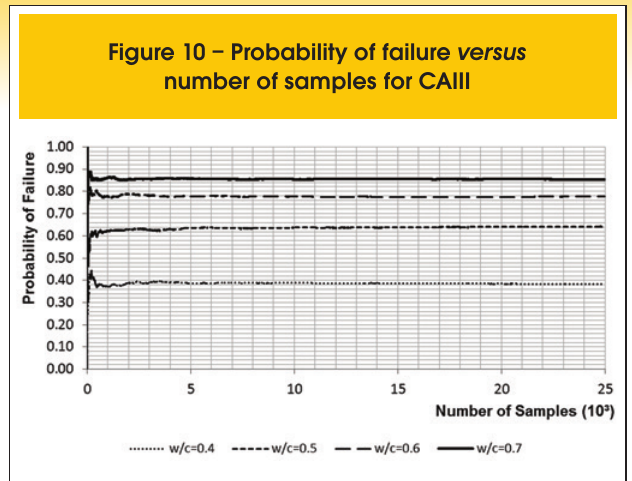
Figure 10 – Probability of failure versus number of samples for CAIII